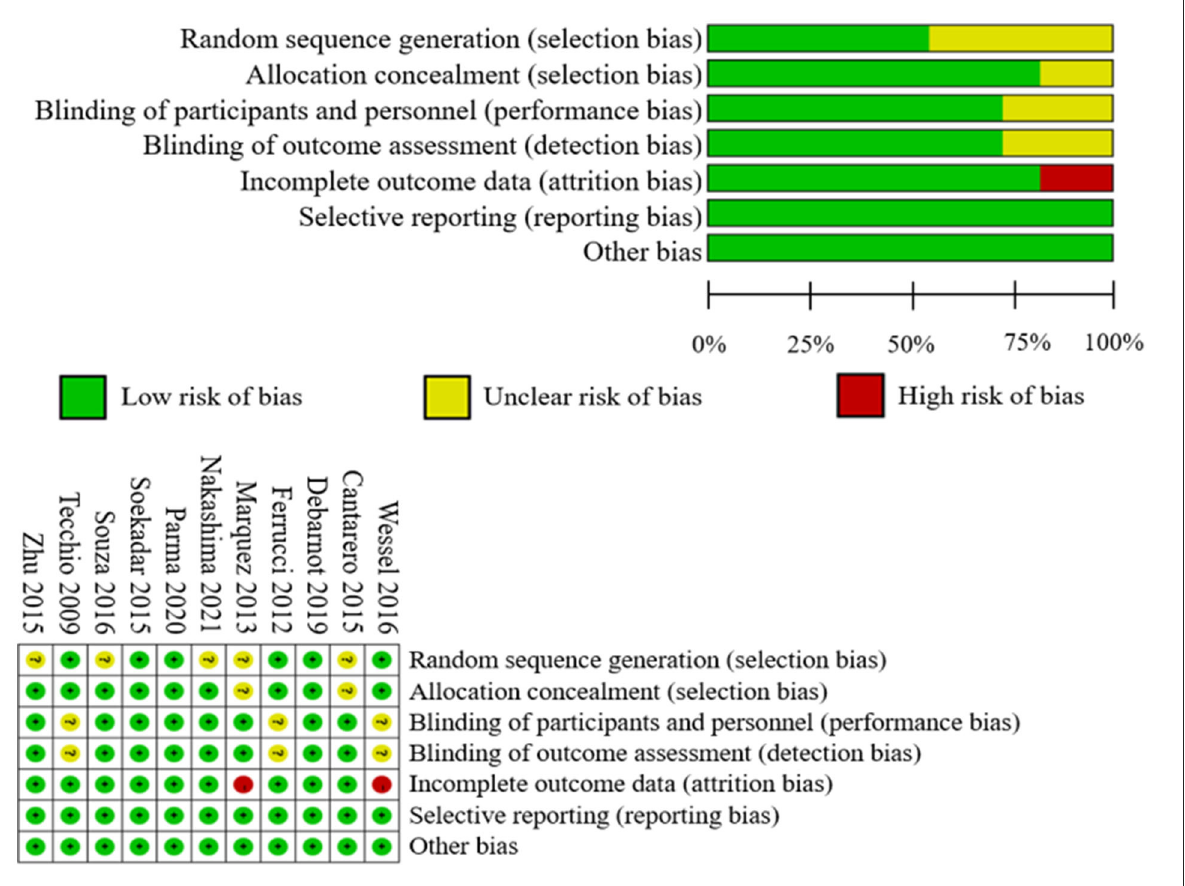
FIGURE4 Summary of risk-of-bias